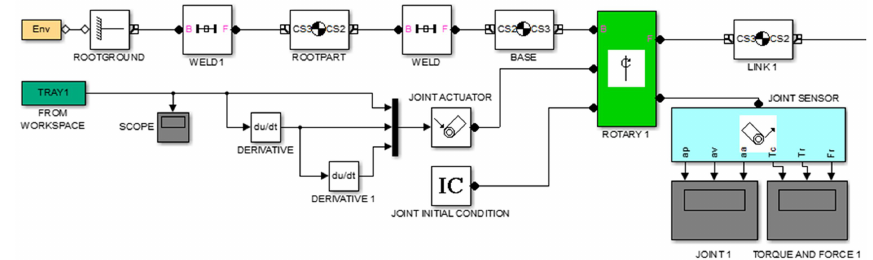
Figure 6. Control loop of the first rotary joint of the 6-DoF redundant planar manipulator